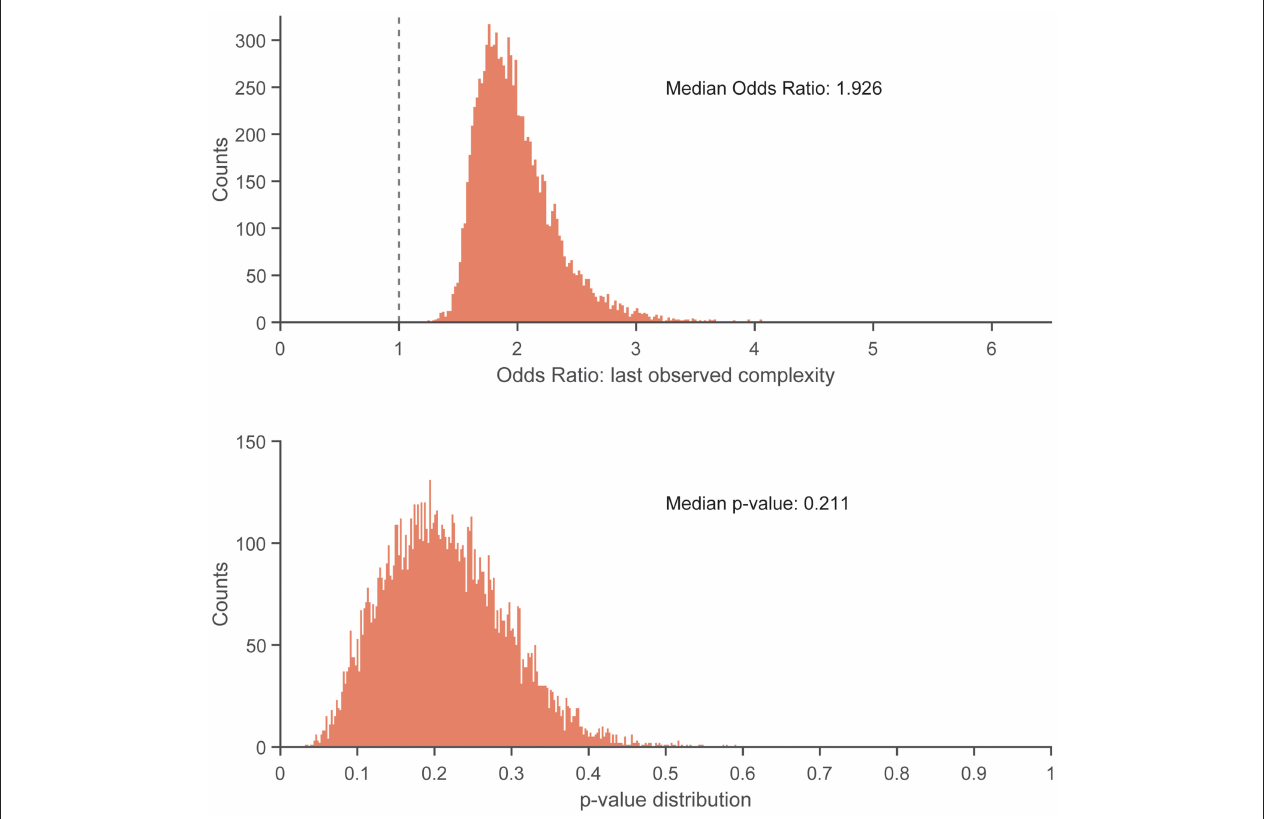
FIGURE 5 | Histogram showing distribution of odds ratios (Top) and p -values (Bottom) for the increase in injury odds per 0.1-unit increase in pre-injury complexity, across 10,000 replicates of the frequency-matching procedure. “Pre-injury” complexity was the last observed complexity value prior to reported injury in the injured group and the date-matched run of the control group resulting from the frequency-matching procedure. The vertical dashed line in the top panel indicates the null hypothesis of no association (odds ratio = 1.0). 100% of the replicates resulted in an odds ratio >